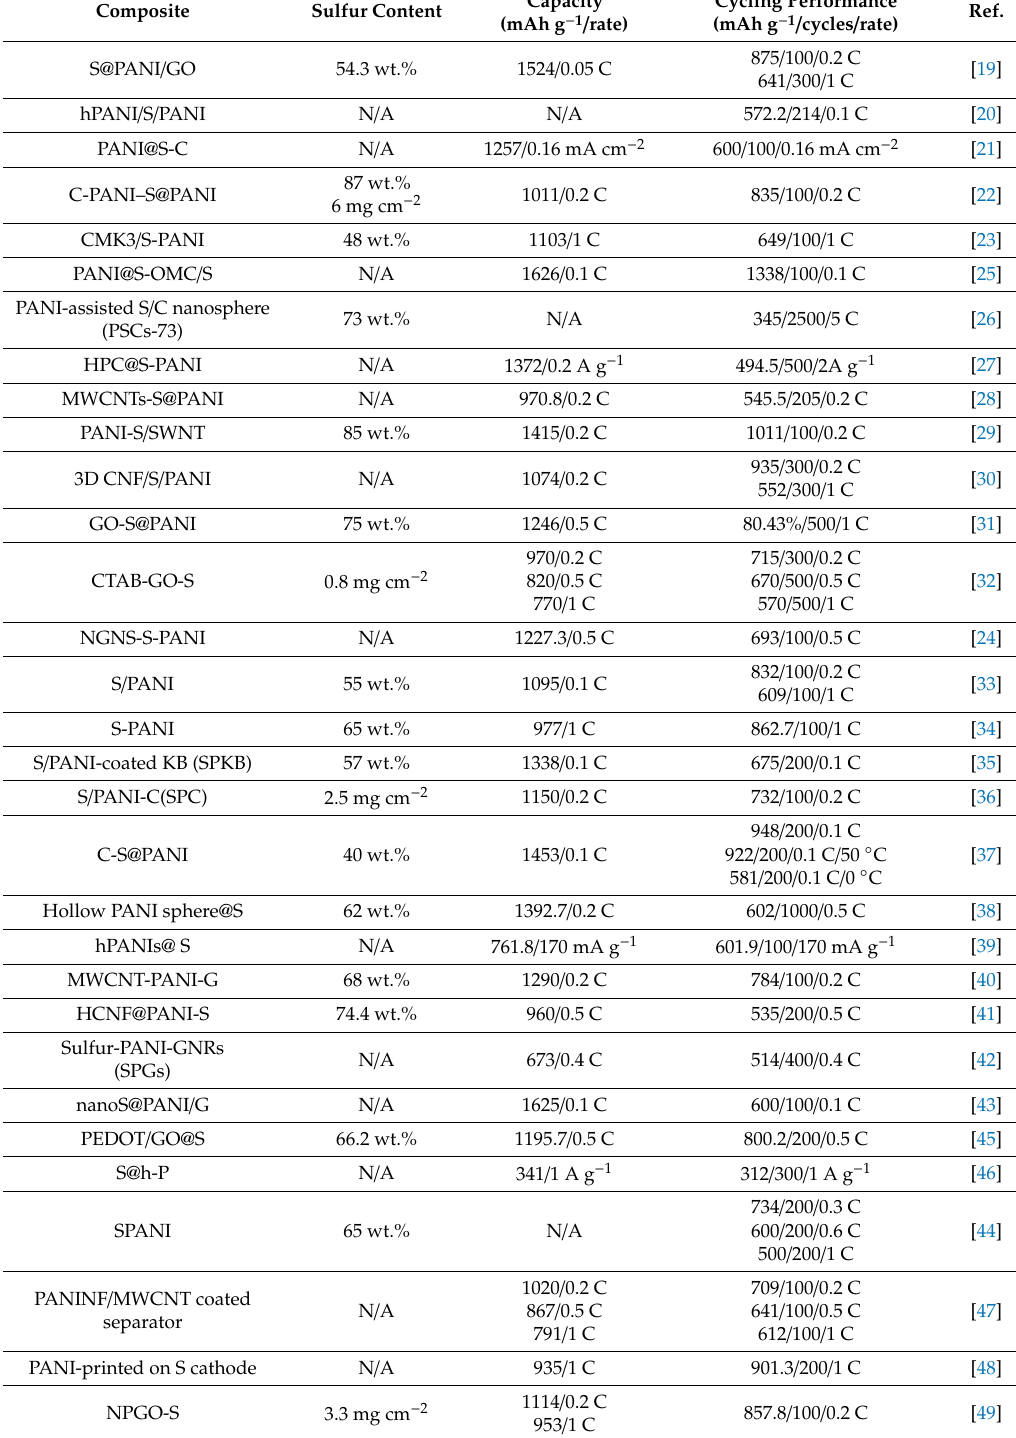
Table 1. The performance of PANI-based composites in Li-S